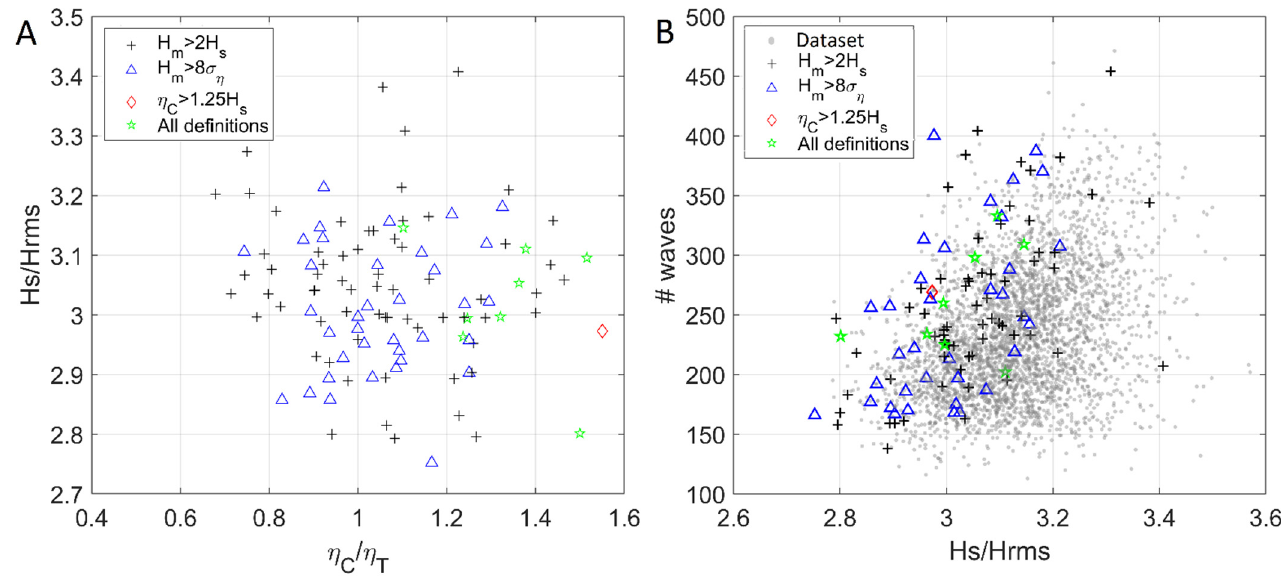
Figure 3. Crest to trough symmetry of waves; detected rogue waves datasets (H/Hs above 2) are marked in accordance with the threshold definition as standard definition H ≥ 2Hs denoted by +; crest height η c ≥ 1.25Hs denoted by ♦ ; STD of the instantaneous water elevation fluctuations H ≥ 8 σ η denoted by ∆ ; corresponds to all three threshold definitions denoted by ☆ ; datasets not answering on any of the rogue thresholds are denoted by red dot sign.